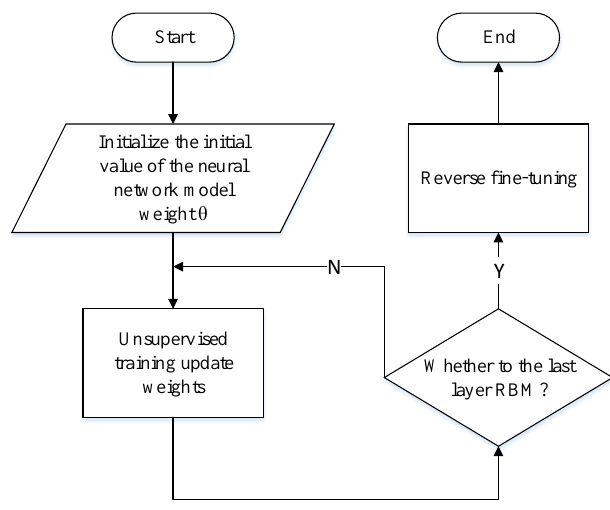
Figure 4. DBN training flowchart.